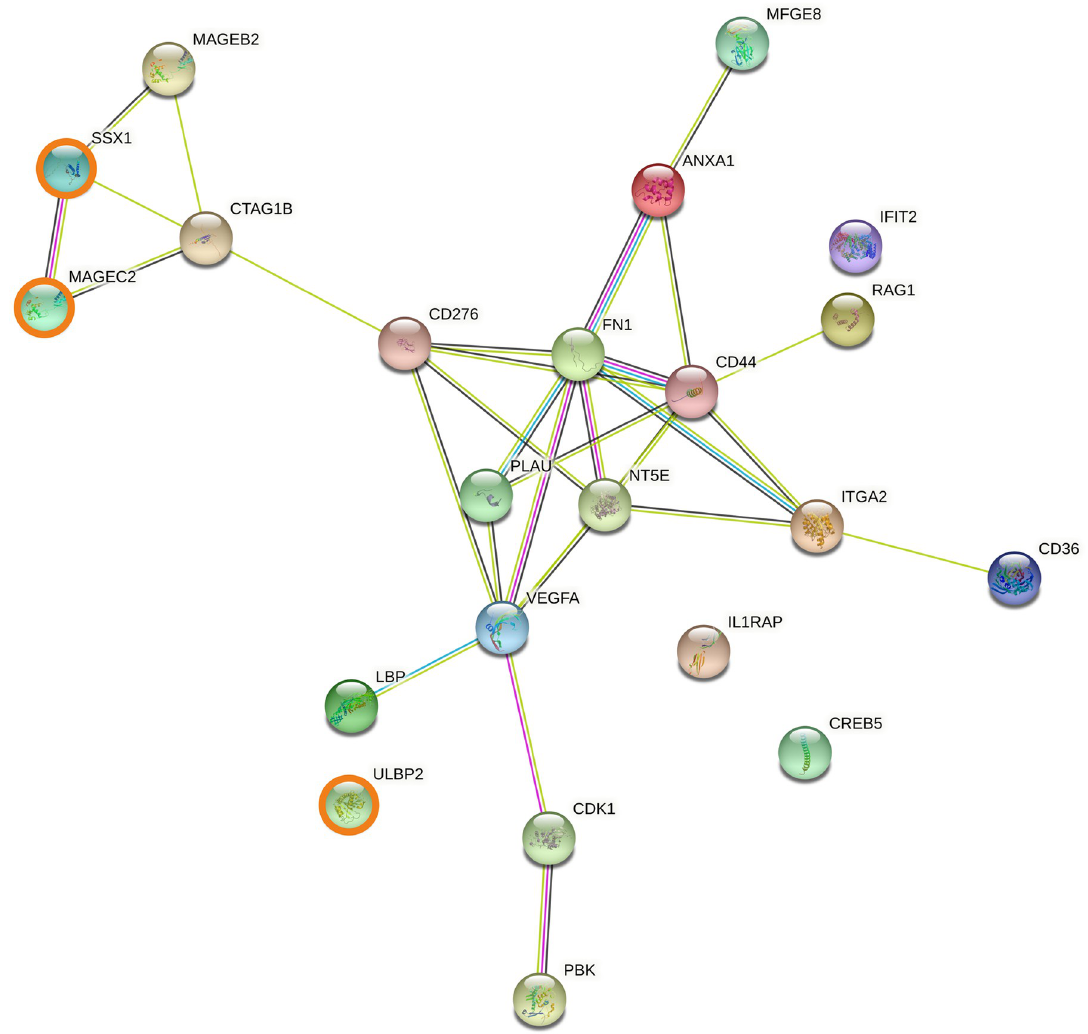
Fig 7. Protein association network analysis using STRING in solid cancer patients. The predicted protein-protein interactions of significantly up-regulated genes (FDR < 0.05, LogFC > 0.5) from the differential expression analysis incorporating only solid cancer patients (n = 293). SSX1, MAGEC2 and ULBP2, the three genes found to be upregulated in both solid and blood patient cohorts, are shown in